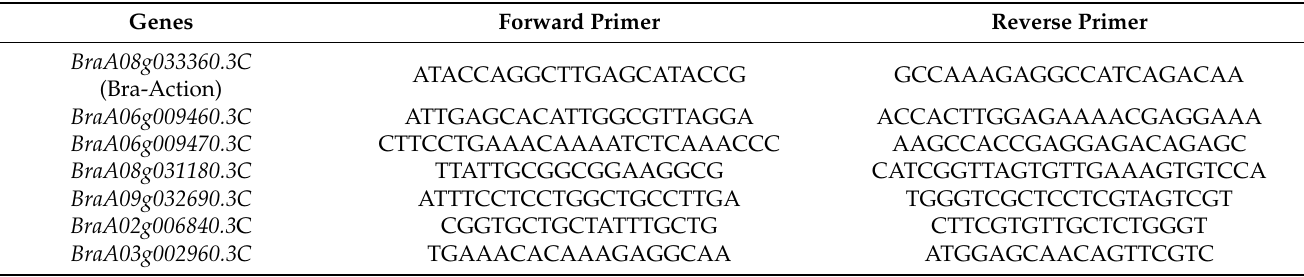
Table 6. Sequences of primers used in the study. Forward